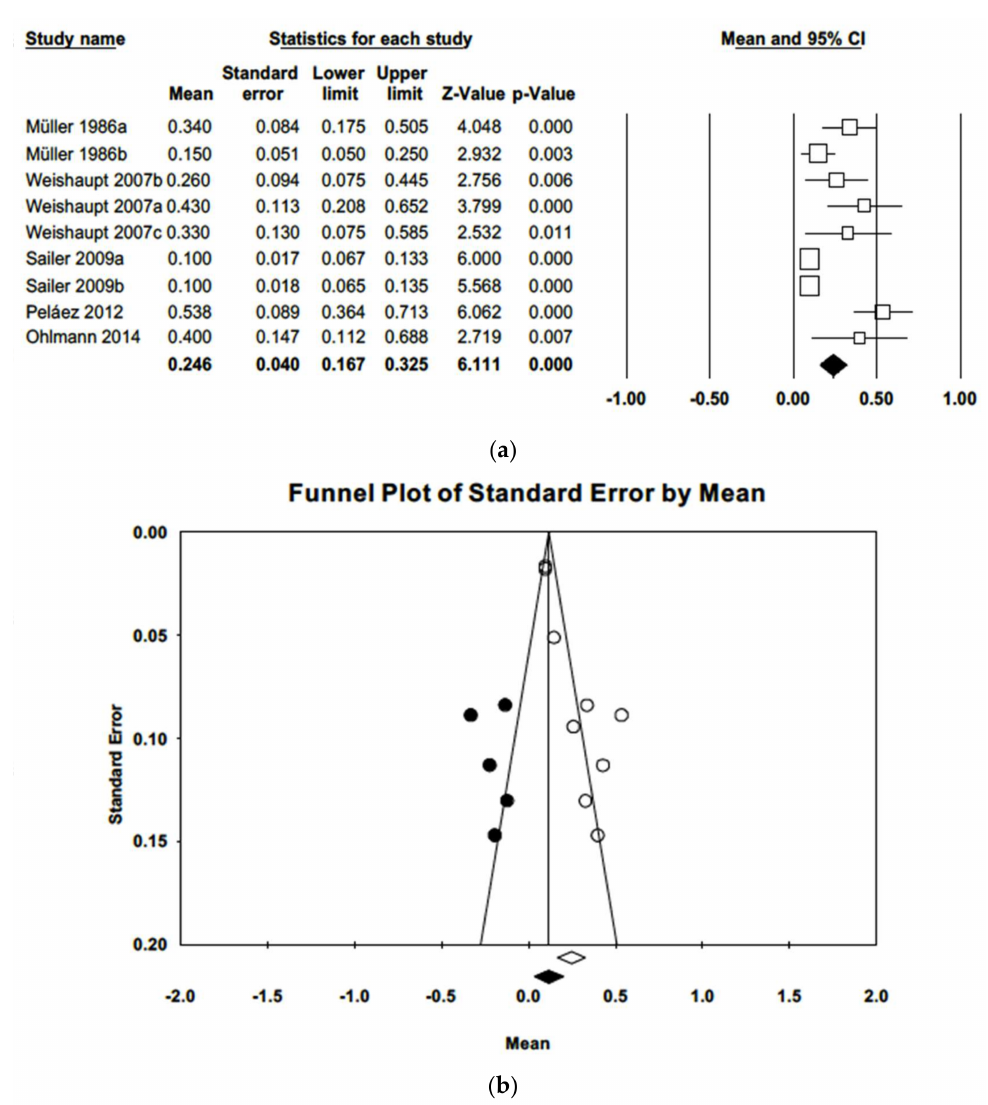
Figure 2. ( a ) Forest plot of plaque index meta-analysis with observed and imputed studies. ( b ) Funnel plot of plaque index meta-analysis with observed and imputed